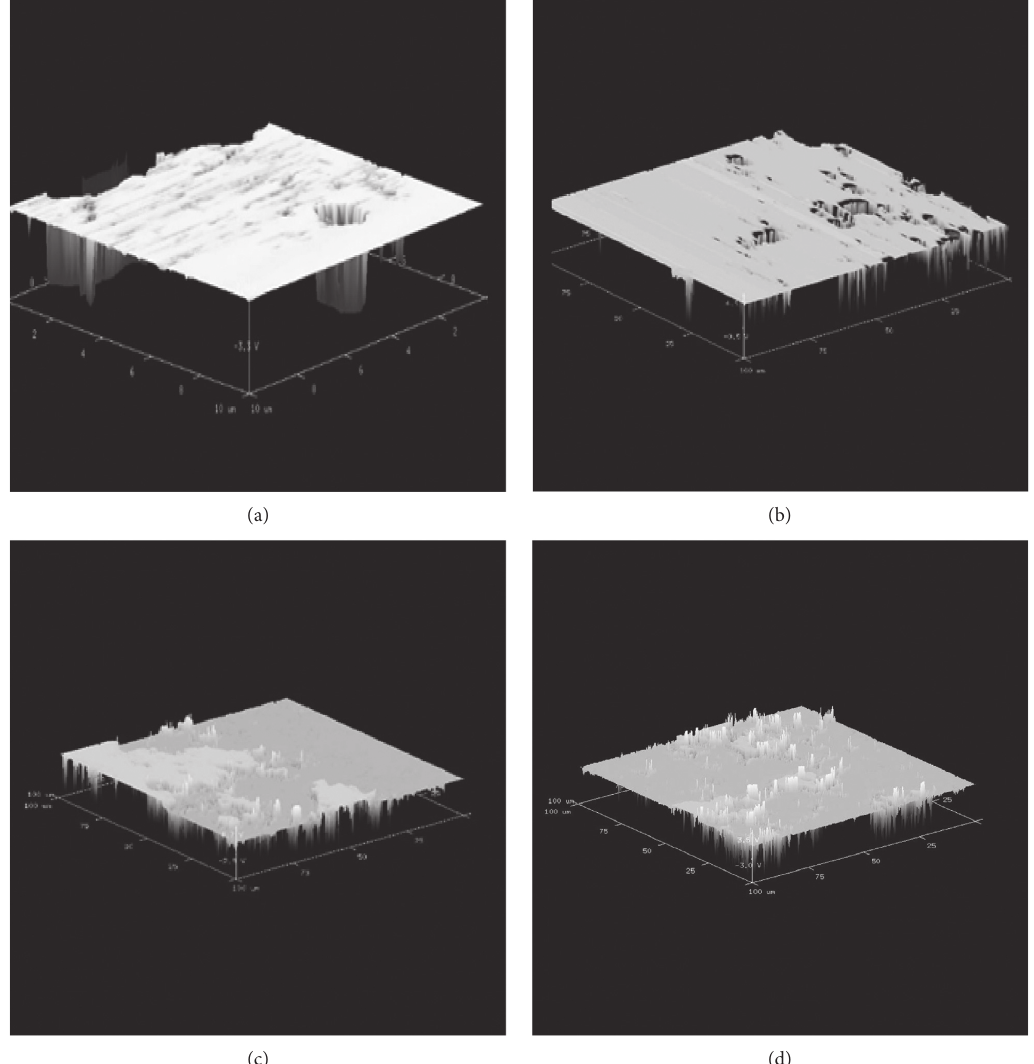
Figure 3: AFM captures of hydroxyapatite discs. (a) A disc straight out of the package. (b) An acid-damaged hydroxyapatite disc. (c) A disc treated with 1.0 mg/mL phosvitin and (d) a disc treated with 1mg/mL BSA were exposed to acid damage for one month and then imaged by